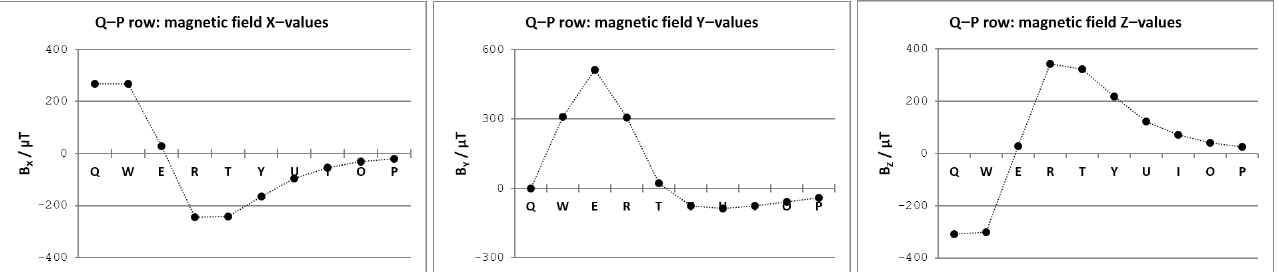
Figure 10. Magnetic field fingerprints for the virtual keyboard top-row (letters from Q to P).